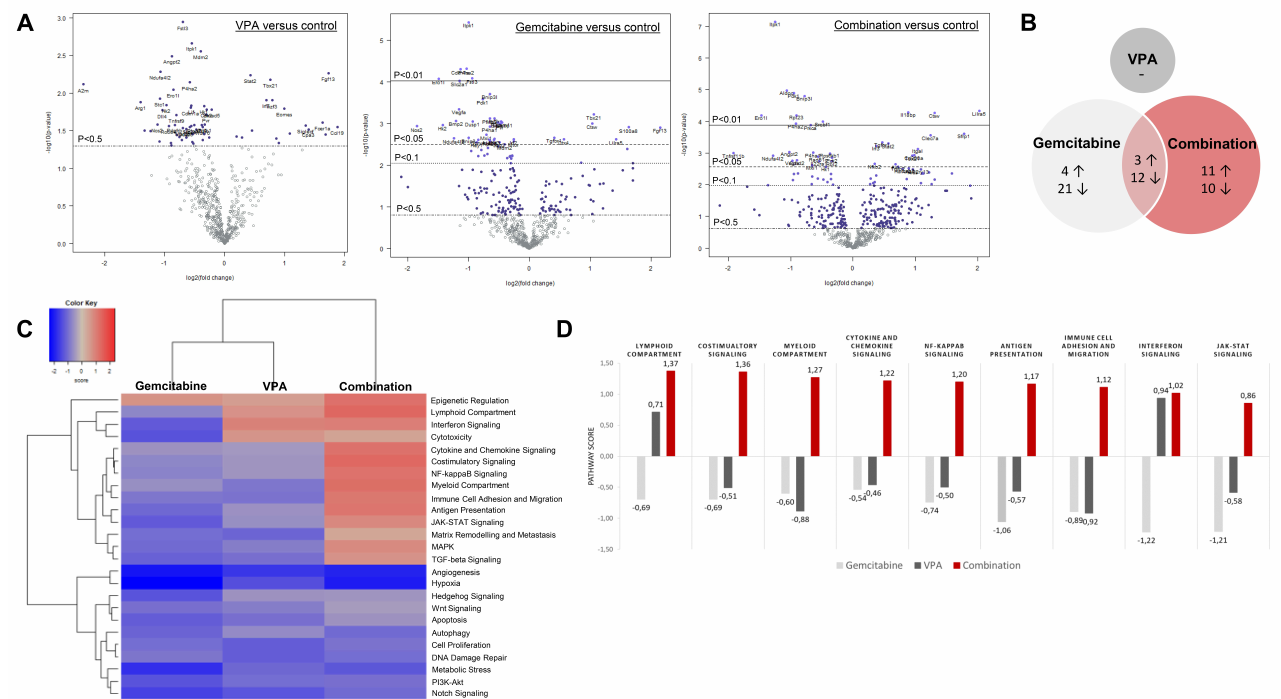
Figure 6. Nanostring analysis PanCancer IO 360 panel. ( A ) Volcano plot displays each gene’s − log10( p -value) and log2 fold change with the selected covariate. Highly statistically significant genes fall at the top of the plot above the horizontal lines, and highly differentially expressed genes fall to either side. Horizontal lines indicate various p -value thresholds. The 40 most statistically significant genes are labelled in the plot. ( B ) Venn diagram shows the number of up- and down- regulated genes in the three treatment arms compared to control. Overlapping areas represent the number of genes that were altered by both treatment arms. ( C ) Heatmap displays each sample’s directed global significance scores. Directed global significance statistics measure the extent to which a gene set’s genes are up- or down-regulated with the variable. Red denotes gene sets whose genes exhibit extensive overexpression with the covariate, blue denotes gene sets with extensive under expression. ( D ) Pathway scores of immune-related pathways. Increasing pathway scores corresponds to increasing